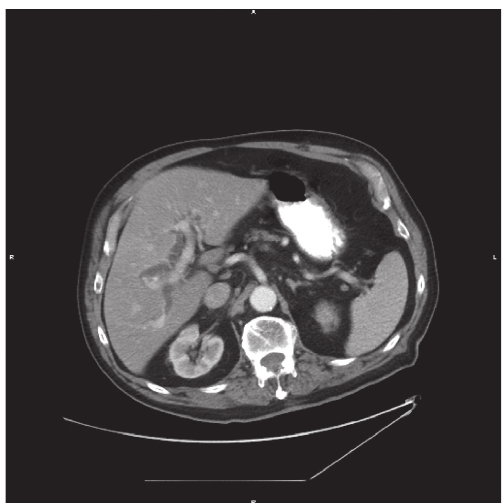
Figure 1: Axial CTof the abdomen with contrast at the level of the junction of the right and left hepatic ducts demonstrates an 11mm hyperdensity likely representing a calculus (arrow). This finding is confirmed on the coronal image (arrow) in Figure 2.